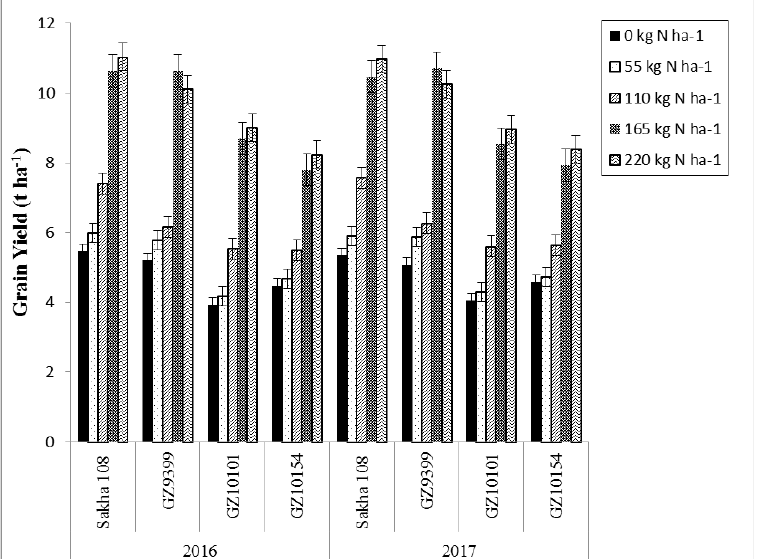
Figure 4: Grain yield (t ha -1 ) as affected by interaction between rice genotypes and N levels in 2016 and 2017 seasons. Vertical bars represent ±standard error (n=4)